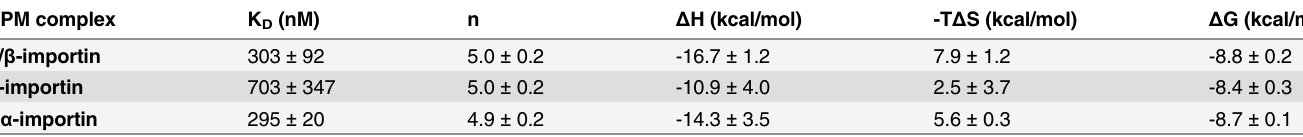
Table 3. Thermodynamic parameters of the importin / NPM interactions determined by ITC. NPM